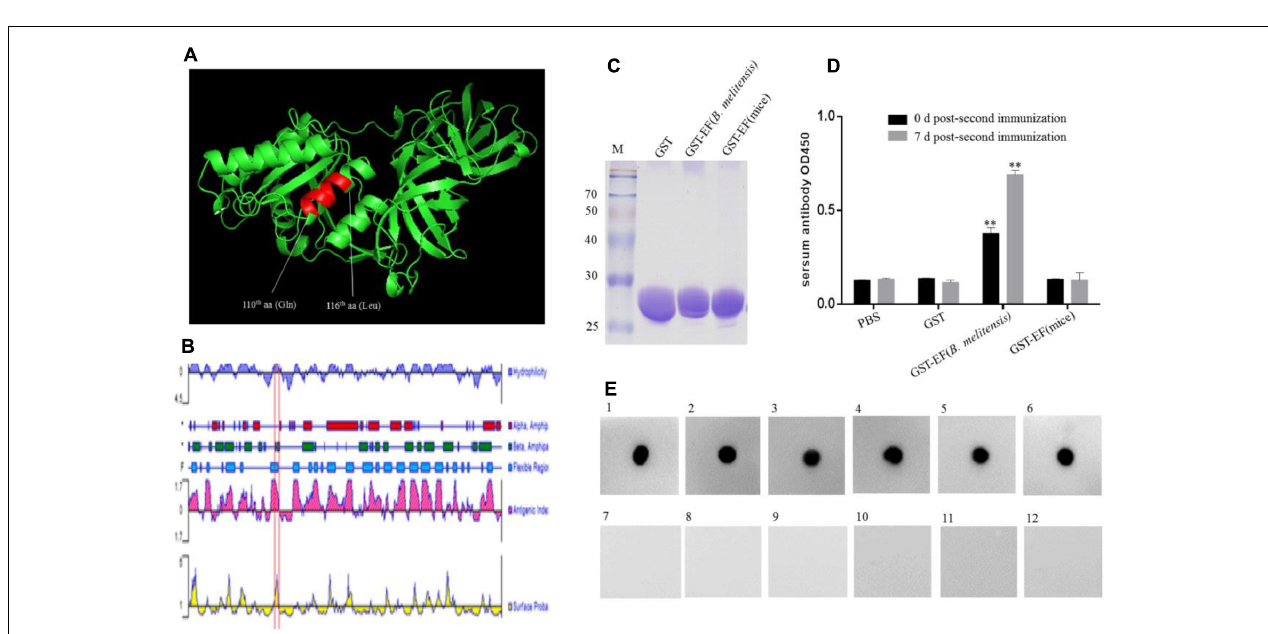
FIGURE 4 | Analysis of the difference of epitope amino acids among different species. (A) Alignment of EF-Tu protein amino acid sequences surrounding the epitope region. The BD 6 epitope amino acid residues are in red box. (B) Western blotting analysis of the reactivity between BD 6 and QTREHLL (human). 1, GST-QTREHIL ( B. melitensis ) recombinant protein, positive control; 2, GST-QTREHLL (human) recombinant protein.